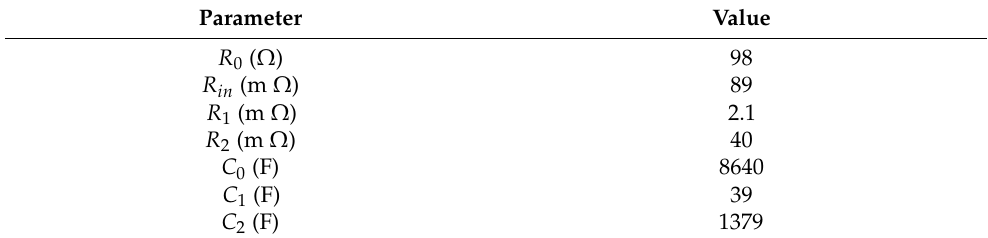
Table 5. Battery cell #3 model parameters.